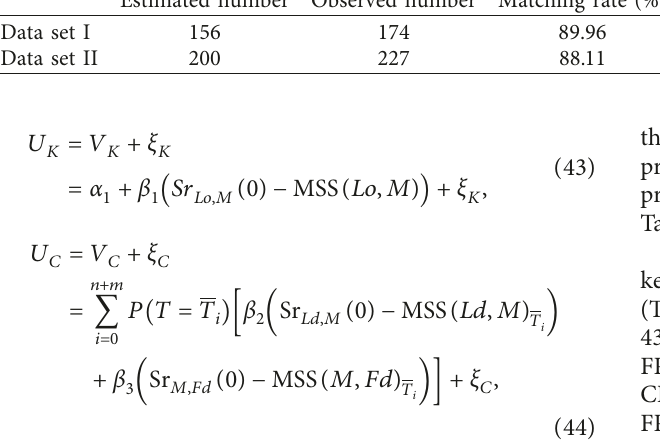
Figure 5: The distribution of cumulative prospect values of lane-changing and lane-keeping (a) for lane-changing samples and (b) for lane- keeping samples. Table 5: Estimated results in data set I and data set II.